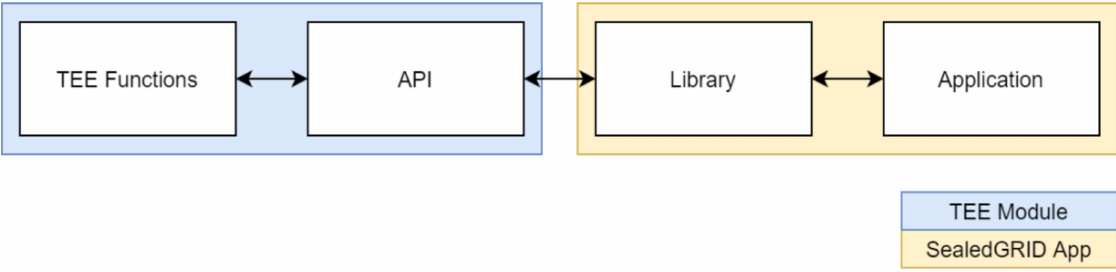
Figure 9. The proposed model of the segmentation between TEE and application